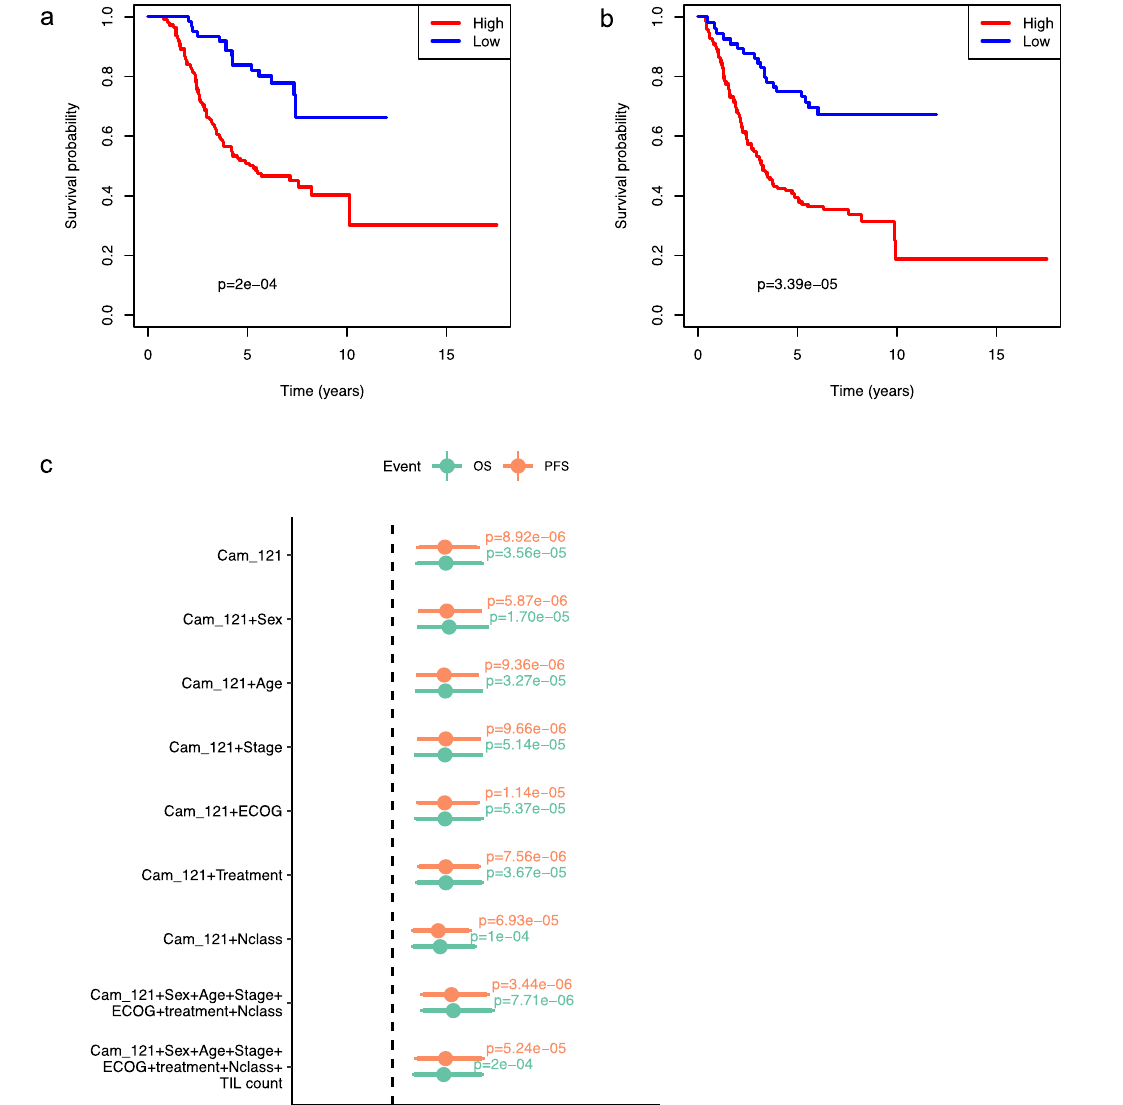
Fig. 1 The Cam_121 gene expression signature is strongly associated with survival in uni- and multivariate Cox regression analyses (AVAST-M primary melanoma cohort; n = 194). Kaplan – Meier survival plots comparing the survival probabilities ( y -axes) as a function of time in years ( x -axes) of groups with high and low “ Cam_121 ” (quantile 0.33 split) for outcomes a overall survival (OS) and b progression-free survival (PFS). The p value of a two- sided logrank test comparing the survival distributions of both groups are indicated. c Forest plot indicating the hazard ratio (HR) estimates relating to the Cam_121 signature when predicting OS (green) and PFS (orange) by means of Cox proportional hazard models controlling for different (sets of) clinical variables ( y -axis). The HR estimates are indicated by the dots at the centre of the error bars; the horizontal error bars correspond to the 95% con fi dence intervals of the HR. The two-sided Wald t test p values corresponding to the signature “ Cam_121 ” parameter are indicated for each model and outcome. ECOG Eastern Cooperative Oncology Group Performance Status. TIL count Tumour-in fi ltrating lymphocyte